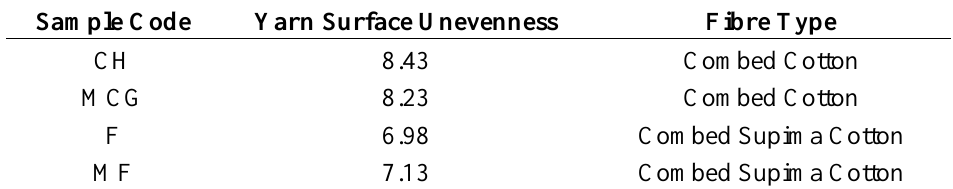
Table 3. Surface unevenness of cotton yarn